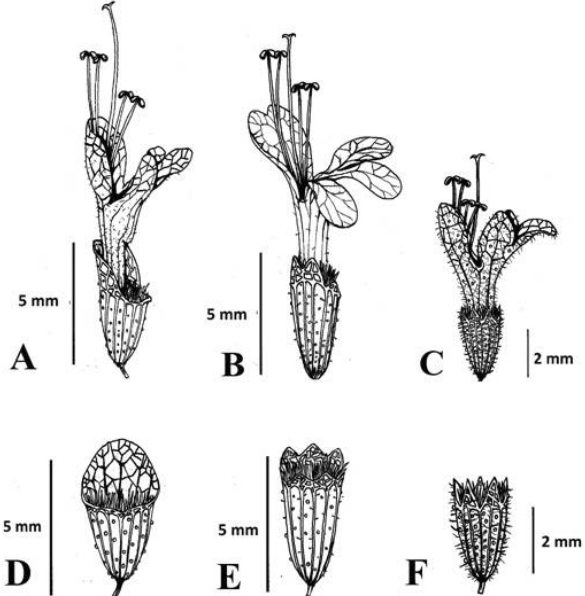
Figure 6. Flower and calyx of O. ayliniae (A, D), O. sipyleum (B, F), O. vulgare subsp. hirtum (C, F) (figures A, D, B, F from Dirmenci et al 2018a and C, F from Dirmenci et al. 2018b).